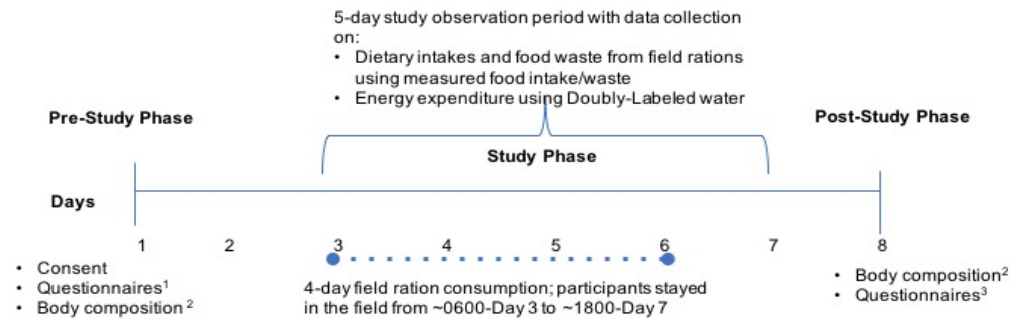
Figure 1. Winter weather (arctic-like) field training exercise experimental protocol. 1 Questionnaires on socio-demographics, PAR-Q + —physical activity readiness questionnaire; 2 body composition assessed using deuterium isotope dilution procedure; 3 end of study questionnaire included questions on body weight maintenance; dietary intakes and food waste from field ration consumption was assessed using a measured food intake / waste collection method; energy expenditure was measured by doubly labelled water (DLW). Study Participants (n = 10) were Class A Reservists, completing a CAF basic military qualification course during a 5-day training exercise.